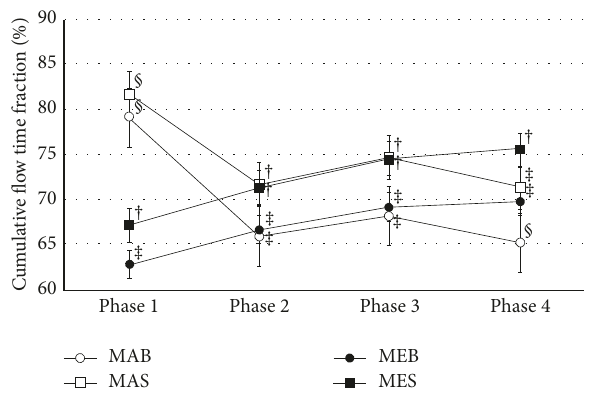
Figure2:Cumulativeflowtimefractionineachphase.Phase1:from initiating CPR at the scene until performing CPR according to 1 of the 4 scenarios, Phase 2: from leaving the scene until entering the elevator, Phase 3: from entering the elevator until exiting it, Phase 4: from exiting the elevator until loading the manikin into an ambulance, MAB: manual compression with bag-valve mask, MAS: manual compression with supraglottic airway, MEB: mechanical compression with bag-valve mask, MES: mechanical compression withsupraglotticairway. † , ‡ ,§significantbetweengroupdifferences demonstrated in the post hoc